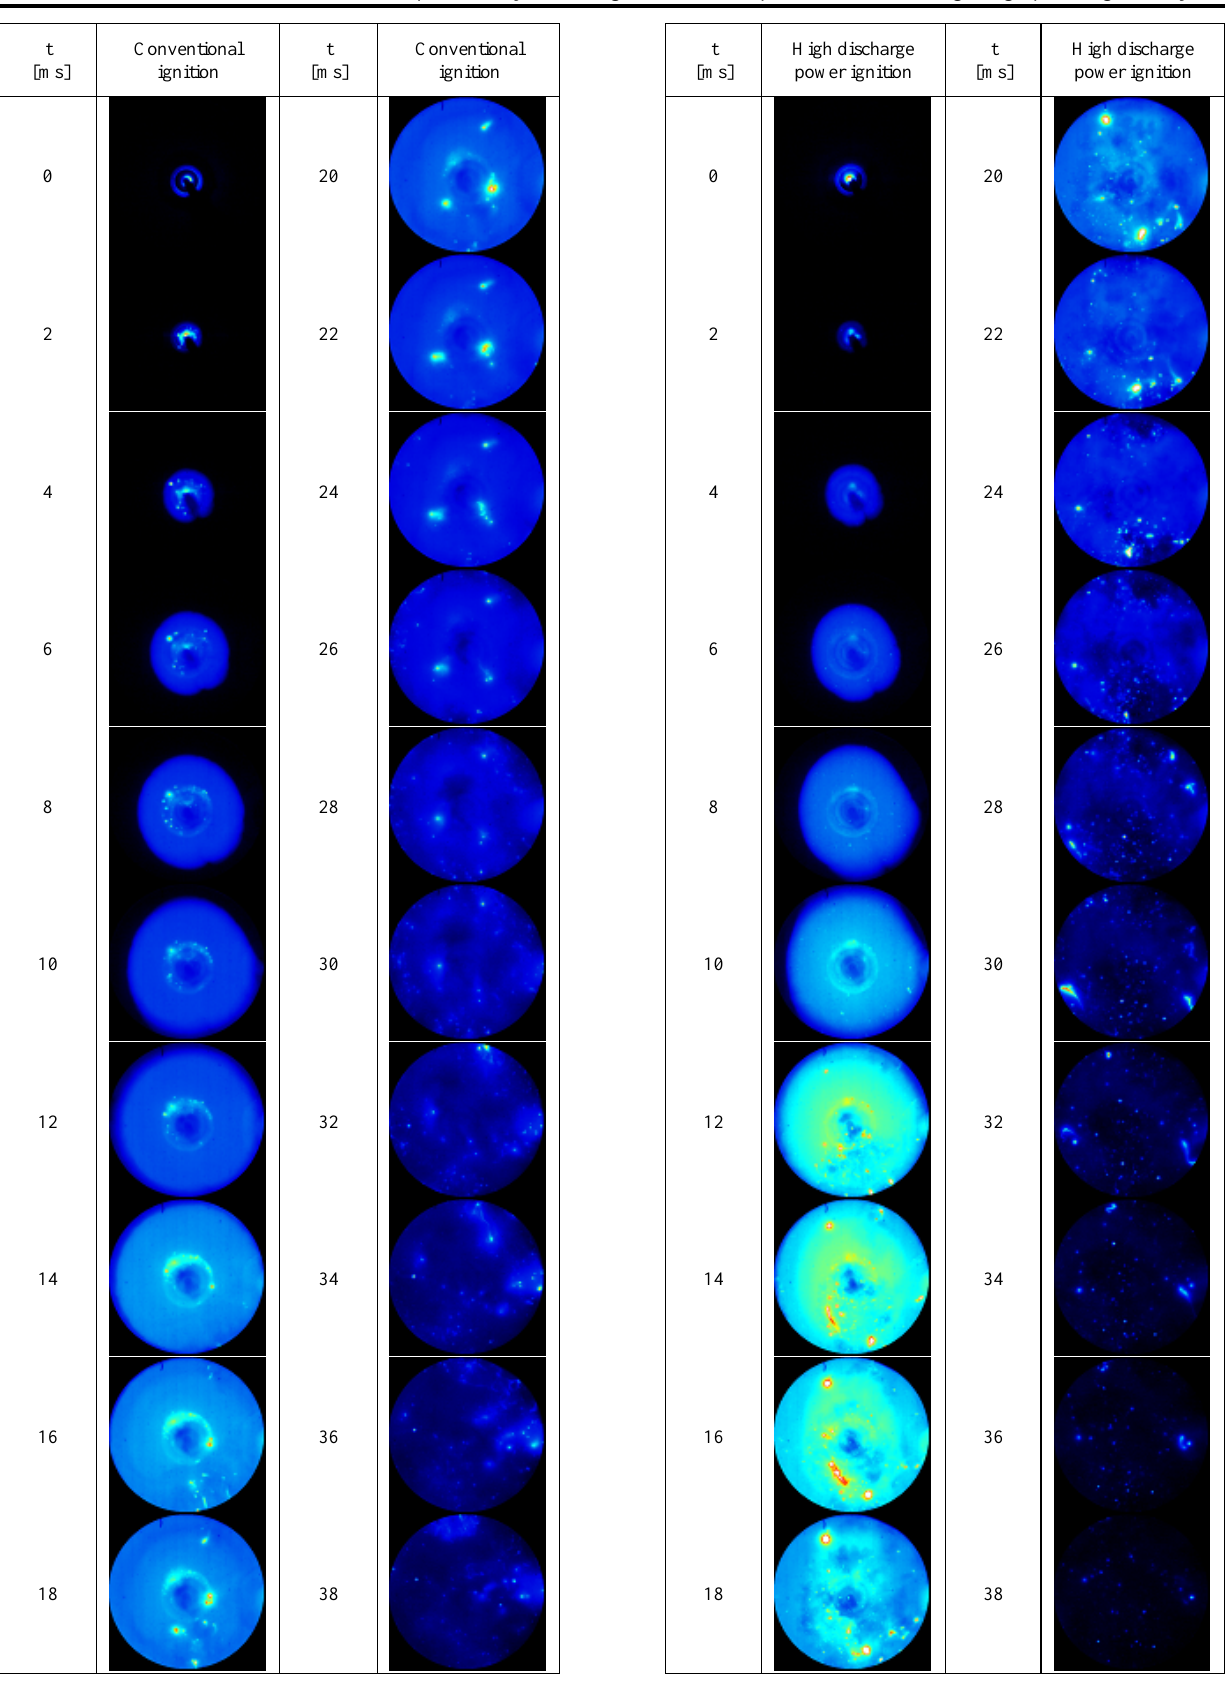
Fig. 6. Selected images of the combustion process using conventional ignition and high discharge power ignition (f = 5 kHz, the first image represents SOI – start of